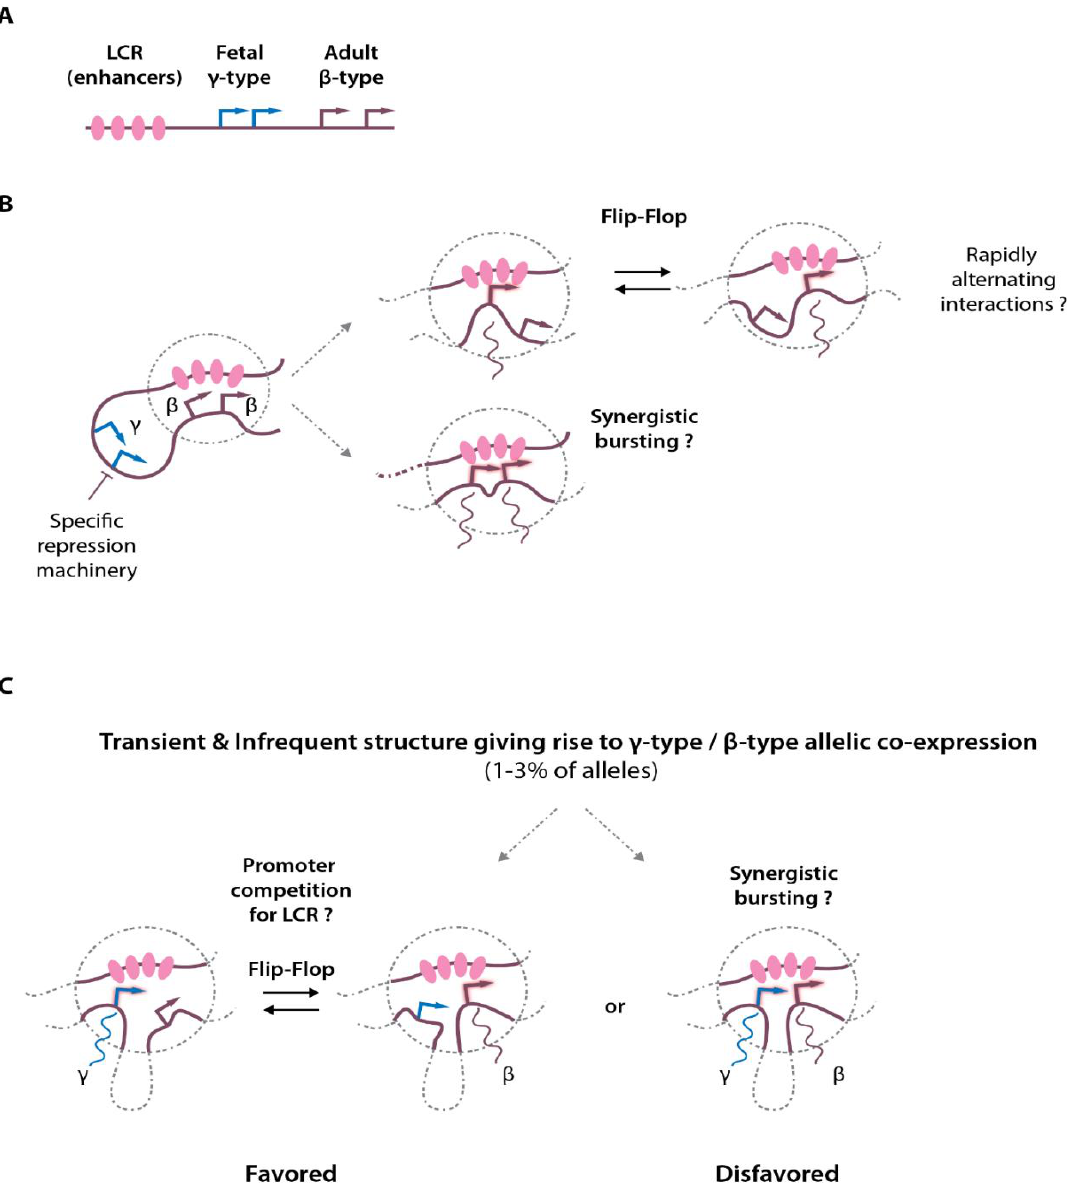
Figure 1. Chromatin interactions at the globin locus, multiway contacts and transcriptional activa- tion. ( A ) Simplified scheme of the β -globin locus showing the enhancers (LCR) and the globin gene transcription start sites (arrows). ( B ) Activation of the adult-type globin genes in adult erythroid cells. Looping between the LCR and the globin promoters allows transcriptional activation that may exist in different flavors: either through rapid alternating contacts (flip-flop mechanism), or through synergistic activation (synergistic transcriptional bursting). Please note that structures containing several promoters and the LCR enhancer hub were detected by Tri-C and MC-4C. ( C ) In a small proportion of cells, concomitant expression of the fetal ( γ -globin) and adult ( β -globin) can be detected on the same allele. The plausible models are depicted, with the flip-flop model being statistically favored.